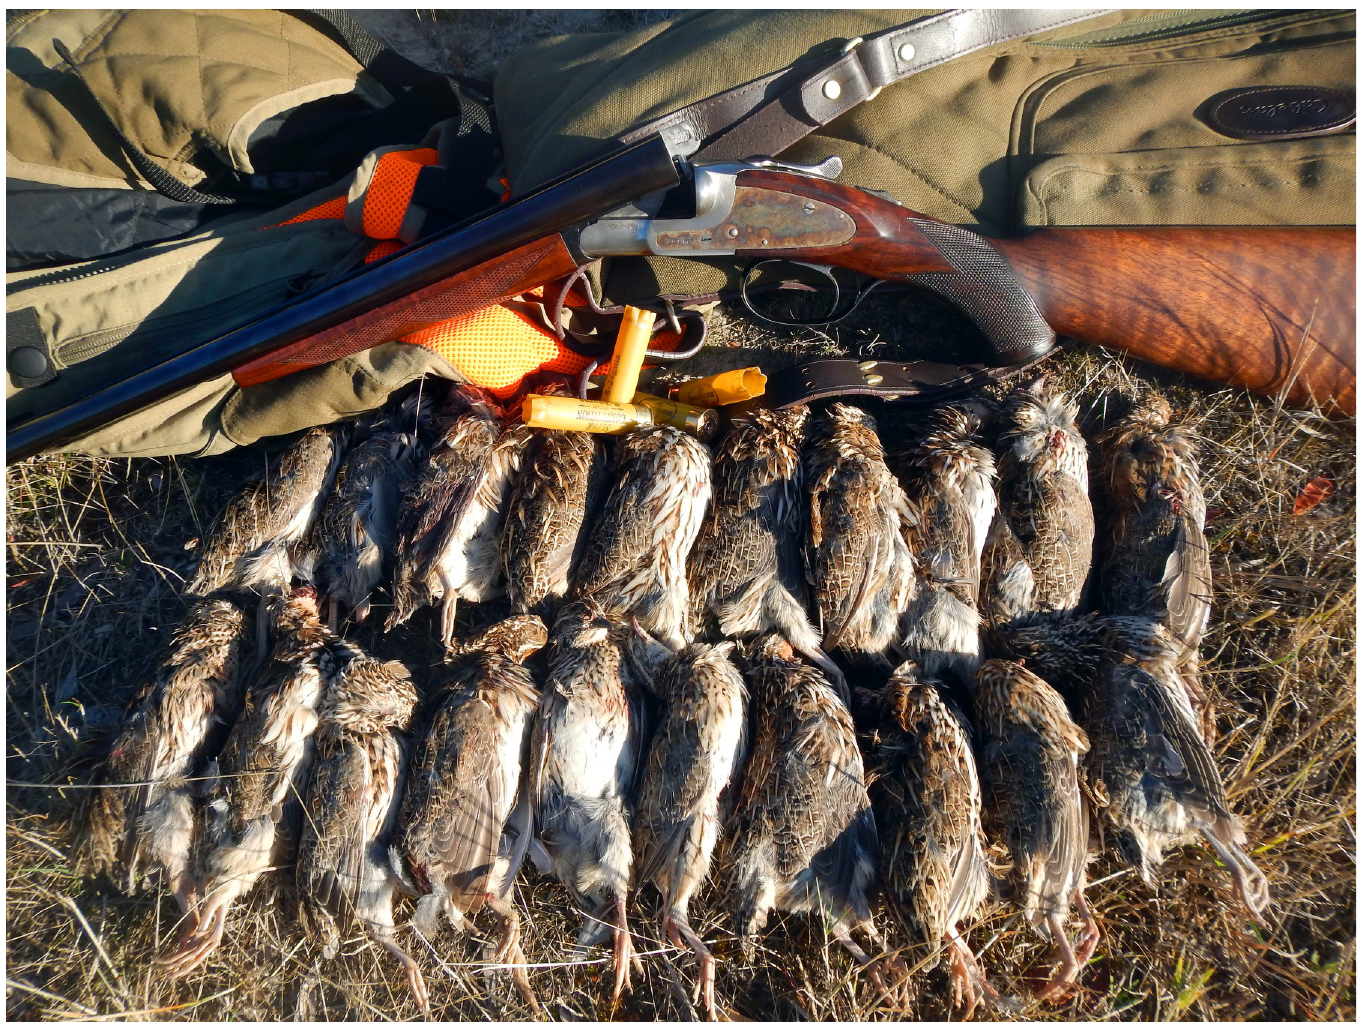
Fig 1. Typical methods used for recreational hunting of stubble quail ( Coturnix pectoralis ) in south-eastern Australia: Shotgun with lead shot. This image shows the size of the birds relative to a firearm and a typical harvest for one hunter in one day: 20 birds. Photo: Heath Dunstan